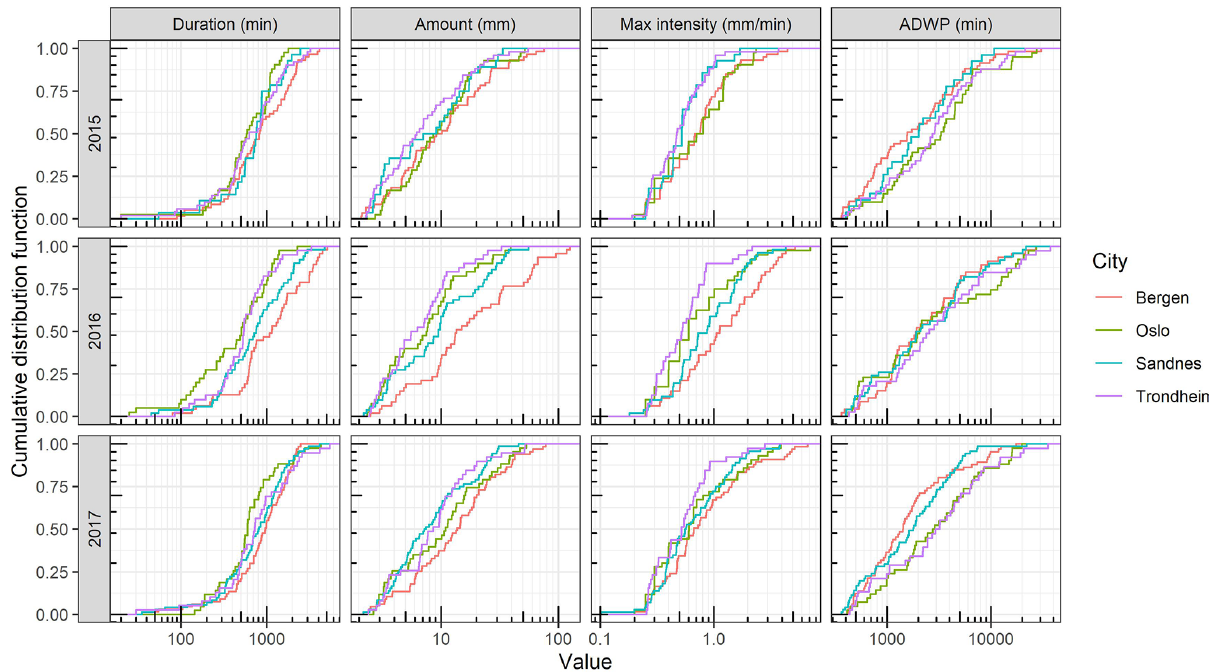
Figure 4. Comparison between the rainfall events at the four Norwegian